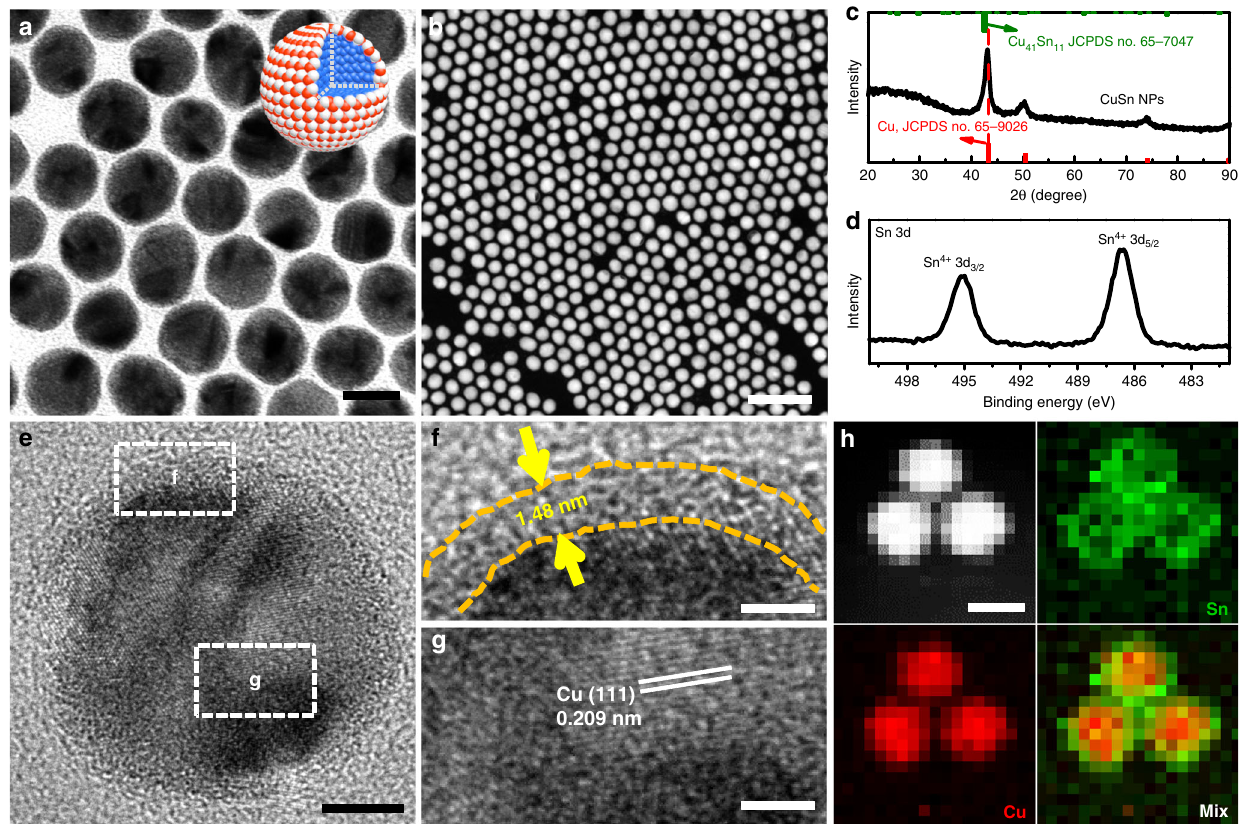
Fig. 1 Structure and phase characterization of CuSn NPs. a Transmission electron microscopic (TEM) image and atom model, b high-angle annular dark- fi eld scanning TEM (HAADF-STEM) image, c X-ray diffraction (XRD) pattern, and d Sn 3d X-ray photoelectron spectroscopy (XPS) pattern of CuSn NPs. e High-resolution TEM (HRTEM) image and f , g the magni fi ed regions in e of CuSn NPs. h HAADF-STEM and energy-dispersive X-ray spectroscopy (EDS) elemental mapping images of CuSn NPs. Scale bars, 2 nm in f , g , 5 nm in e , 20 nm in a , h , 100 nm in b . Red, blue, and white spheres in the model represent O, Cu, and Sn atoms,